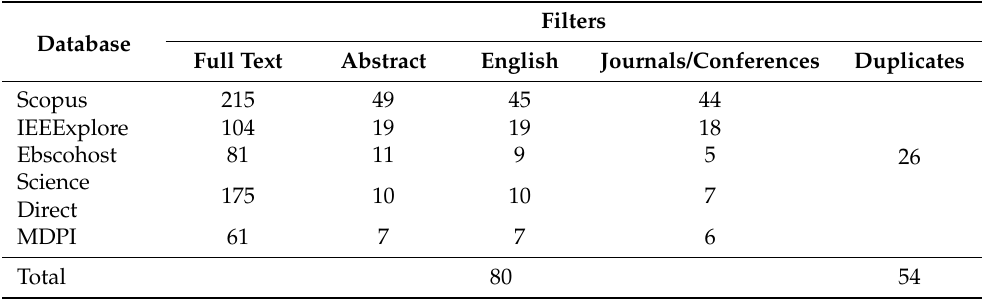
Table 5. Resulting articles after filter application.